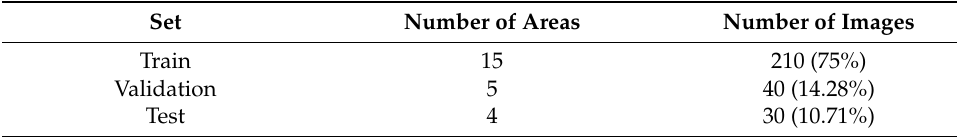
Table 1. Data split in training, validation, and test sets. Set Number of Areas Number of